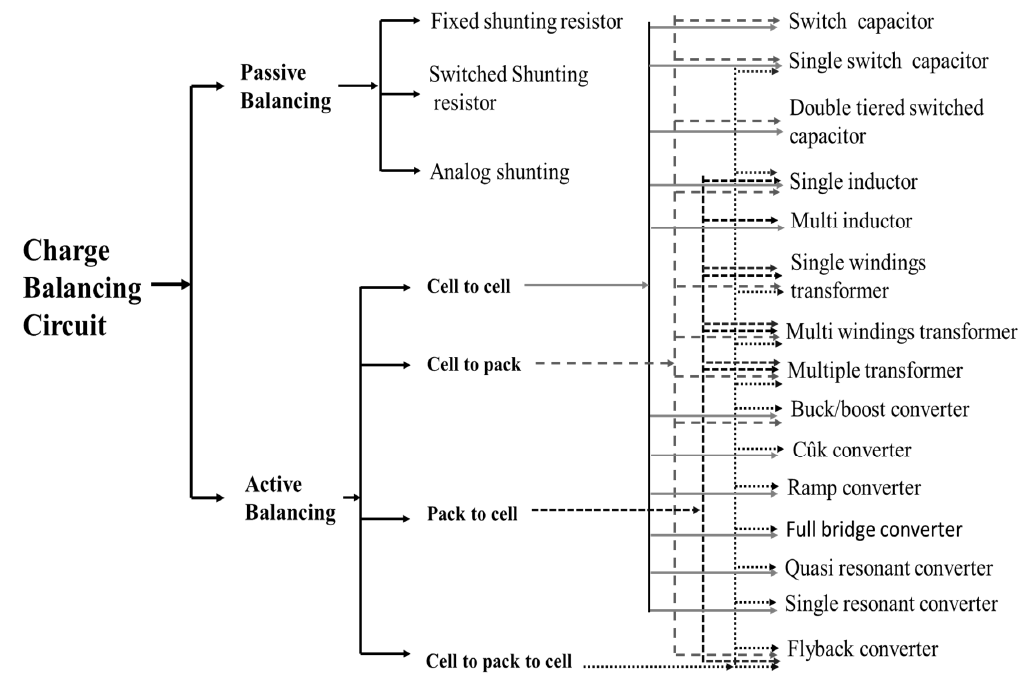
Figure 1. Cell balancing topologies.